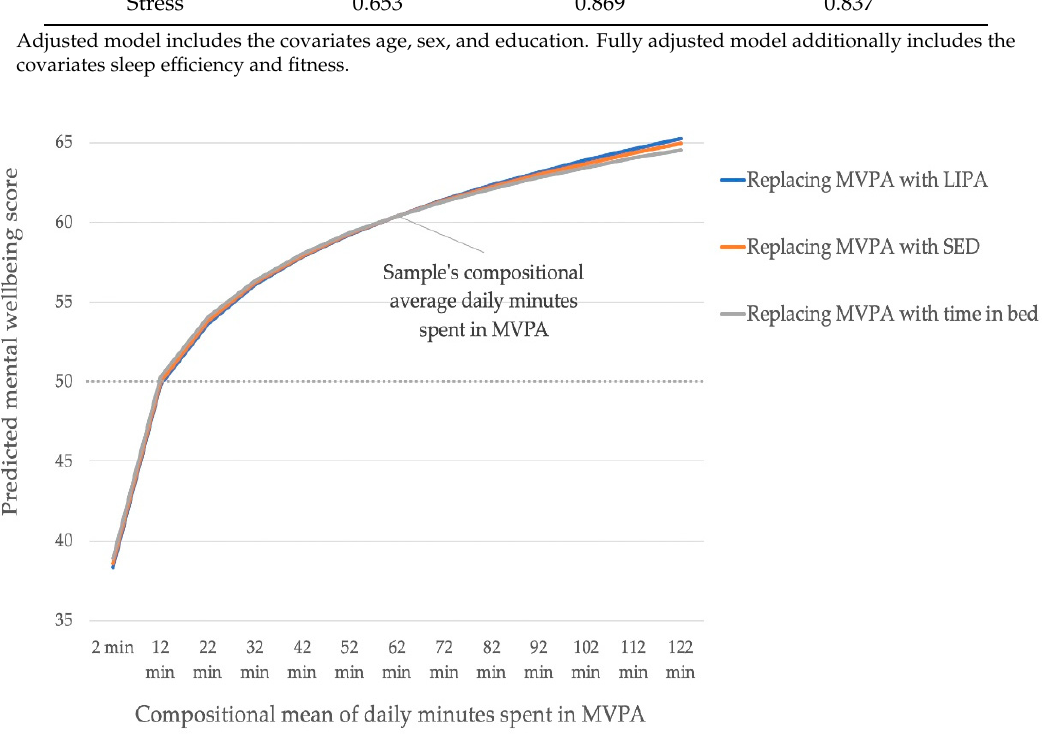
Figure 2. Predicted mental wellbeing scores for theoretically altered 24 h movement compositions. Time between MVPA and remaining behaviors were reallocated in steps of 10 min (one-for-one reallocations). Dashed line indicates cutoff between good mood and low mood (score of 50). MVPA: moderate to vigorous physical activity, LIPA: light intensity physical activity, SED: sedentary behavior.